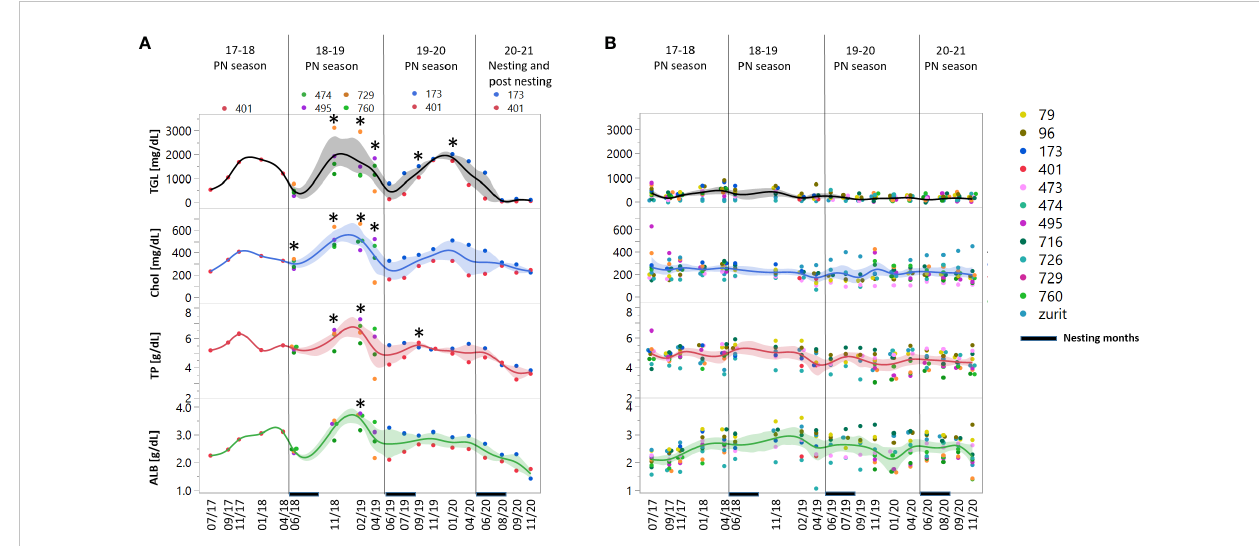
FIGURE 2 Concentration measurements of nutrients and metabolites: triglycerides (TGL), cholesterol (Chol), total protein (TP) and albumin (ALB) in female green turtles, (A) Future nesters (FN) and (B) Non-nesters (NN). Measurements are represented for 19 sampling dates in the period of 2017-2020 divided to 3 pre-nesting (PN) seasons – 2017-18, 2018-19 and 2019-20 and the last nesting/posting season, the nesting period marked at the X axis. At the left panels, asterisk represents signi fi cant difference between the two groups p= 0.05. Shaded areas represent the con fi dence of fi t.